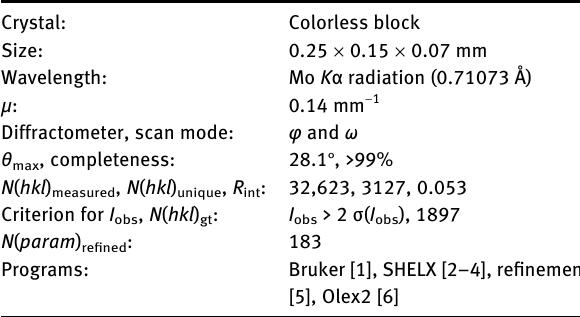
Table 1 contains crystallographic data, and Table 2 con- tains the list of the atoms including atomic coordinates and displacement parameters.